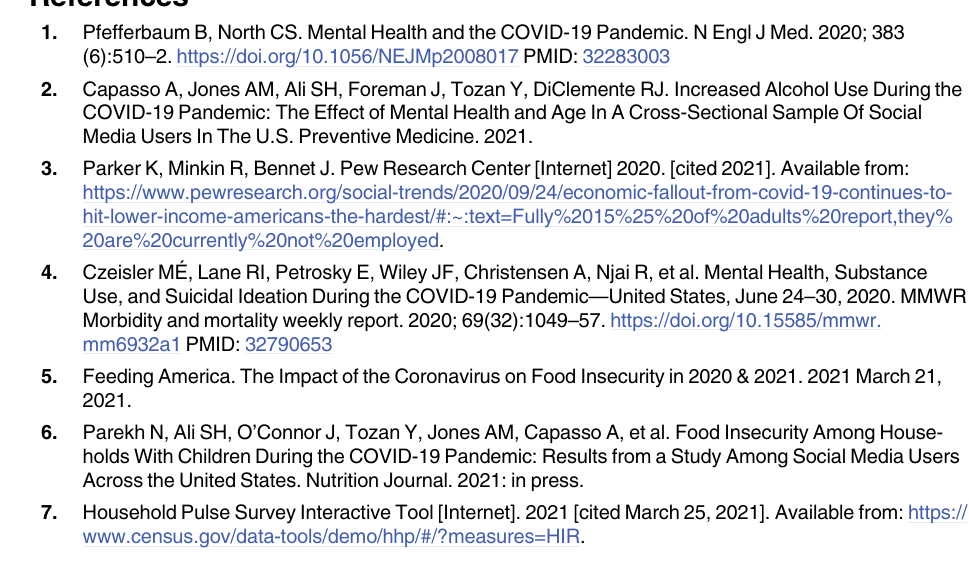
S1 Table. Model fit indices. S2 Table. Model fit indices for the random split samples. S3 Table. Model paths: Unstandardized coefficients with 95% confidence intervals com- paring the full and split sample